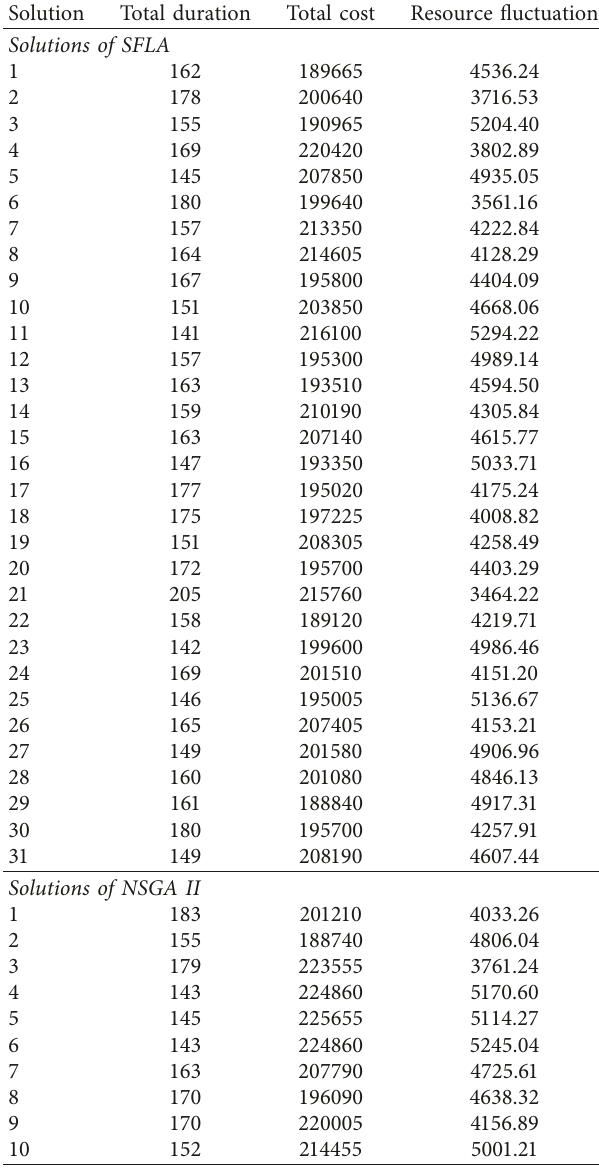
Table 4: Optimal solutions for case study.